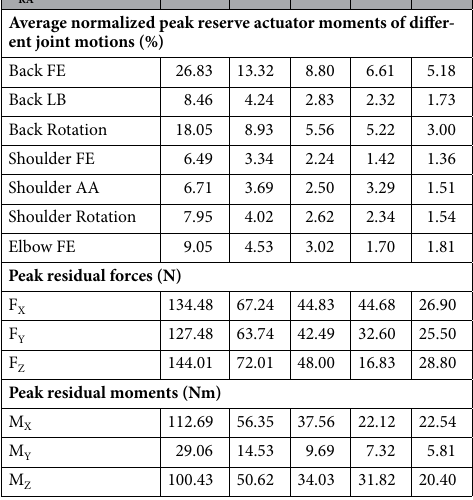
Table 2. Average normalized peak reserve actuator moments of different joint motions ( n = 6), peak residual forces and peak residual moments at five different F RA